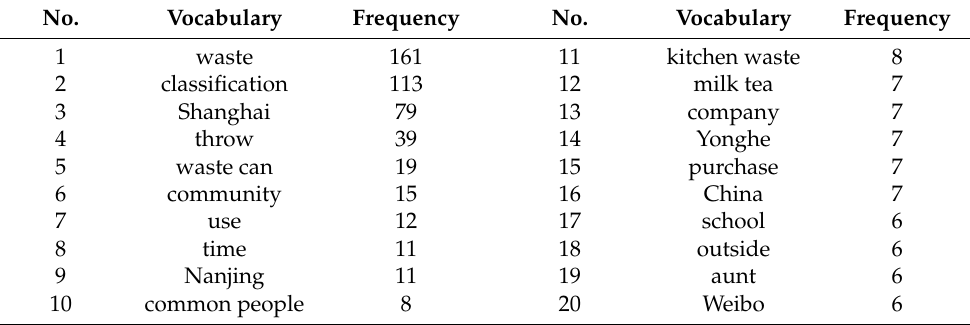
Table 3. High frequency vocabularies in October